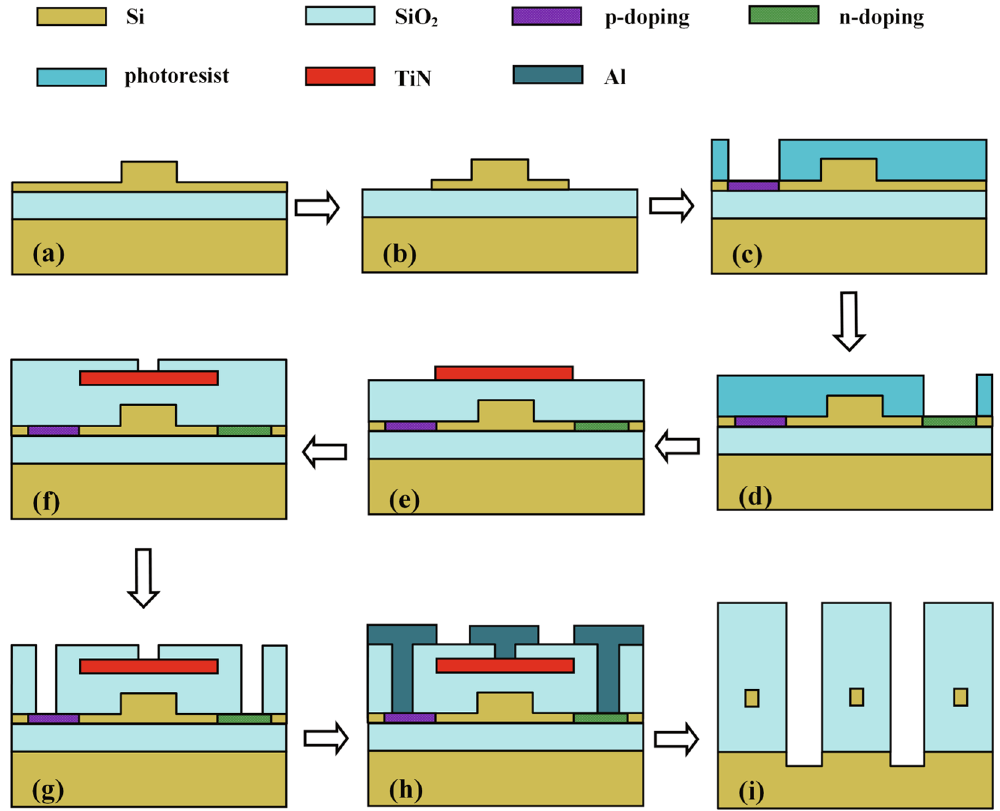
Figure 8. Processing flows of the device: ( a , b ) etching of the top Si layer by 150 nm and 70 nm, respectively, ( c , d ) p- and n- doping and through boron and phosphorus implantation, ( e ) deposition and etching of the TiN layer to form the microheater, ( f , g ) etching of the SiO 2 layer to form the via holes to the PIN diodes and microheaters, ( h ) deposition and etching of the Al layer to form the wires and pads, ( i ) deep etching to form the end-face of the